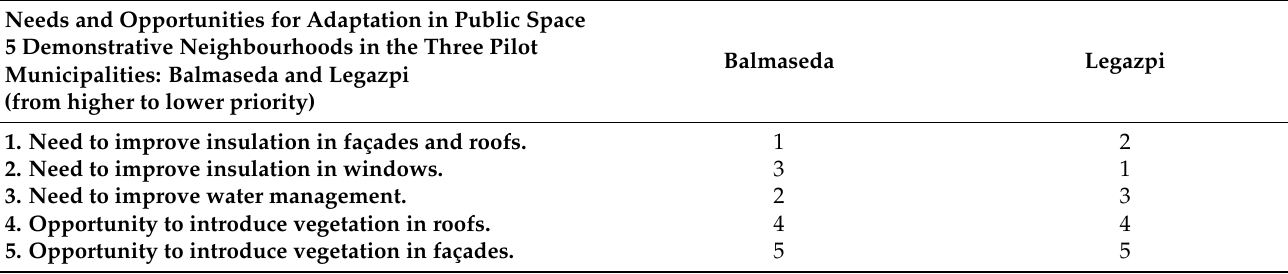
Table 3. Needs and opportunities in buildings (developed by the